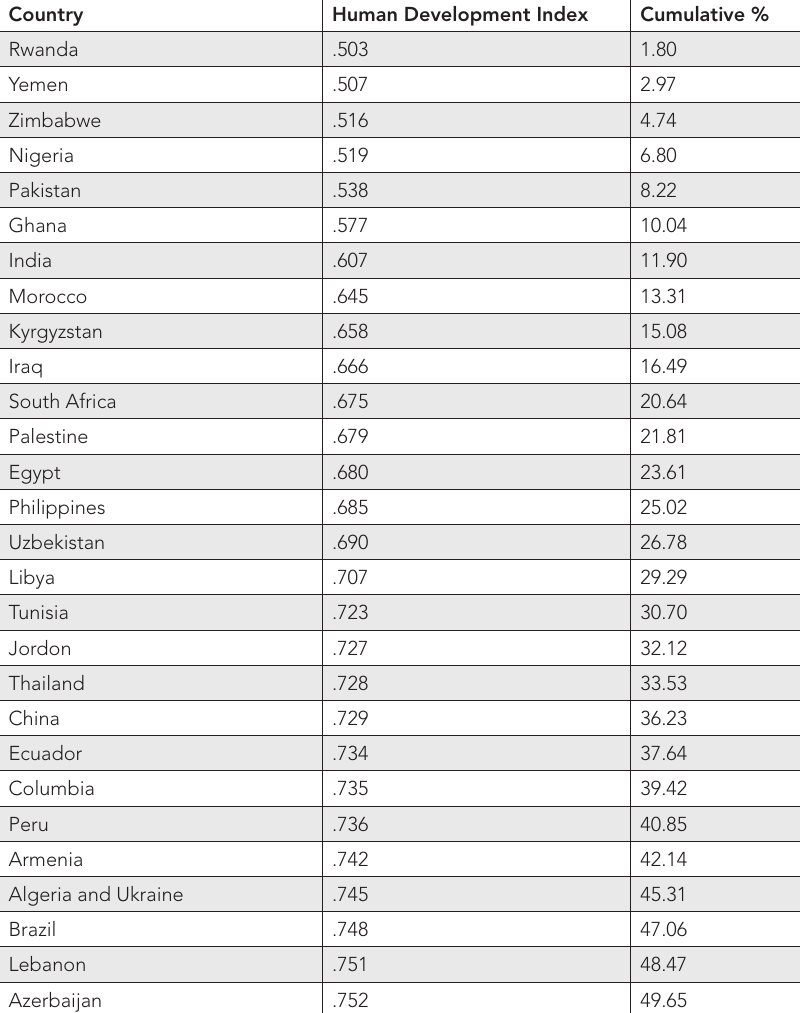
Table A1. Human Development Index (HDI Distribution Across 59